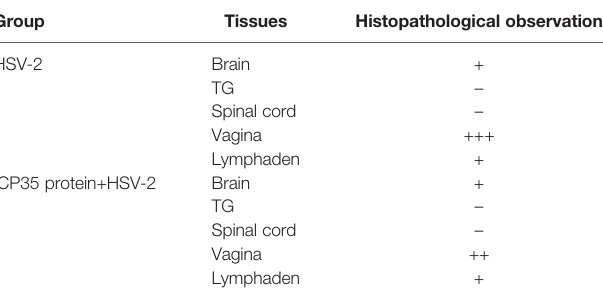
TABLE 3 | Histopathological observation of pathological in fl ammatory reactions in various tissues in the immunized or control mice after viral challenge. Group Tissues Histopathological observation